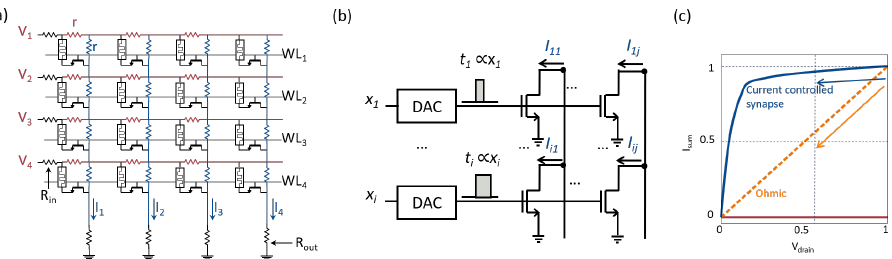
Figure 11. IR drop in crosspoint arrays. ( a ) Explicit representation of the parasitic resistance in a crosspoint array, namely the input resistance R in , output resistance R out and wire resistance r . ( b ) Memory array with current controlled memory element programmed to various saturation currents. ( c ) Comparison of the impact of IR drop for ohmic and saturated characteristics. Reprinted from